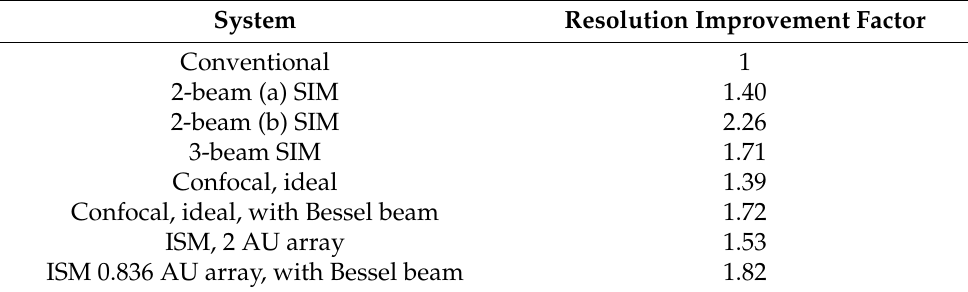
Table 1. Resolution improvement for different